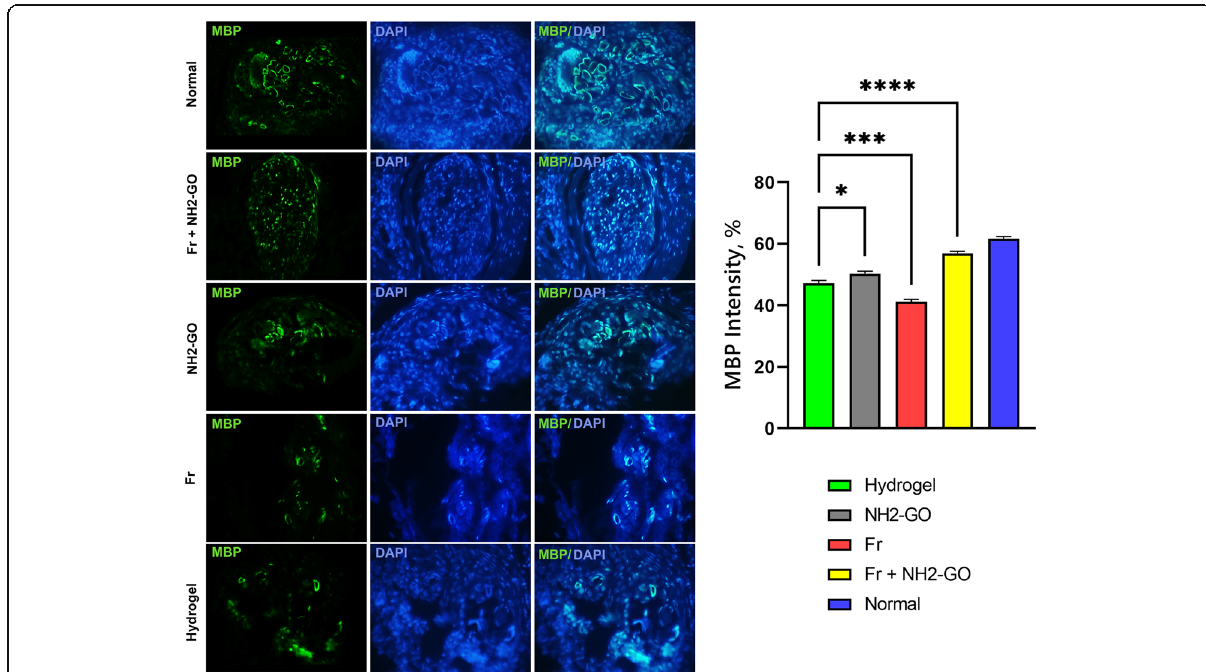
Fig. 5 Immunohistochemical staining of horizontal nerve sections distal to the silicone tube conduit with MBP/DAPI. There was a significant increase in myelination in NH2-GO and Fr + NH2-GO marked by increased intensity of the fluorescent marker. The intensity of MBP positive area in the photomicrographs was analyzed using one-way ANOVA and Tukey test multiple comparison. (*=0.005< p value<0.05, **= 0.0005< p value< 0.005, ***= 0.0001< p value<0.0005, ****= p